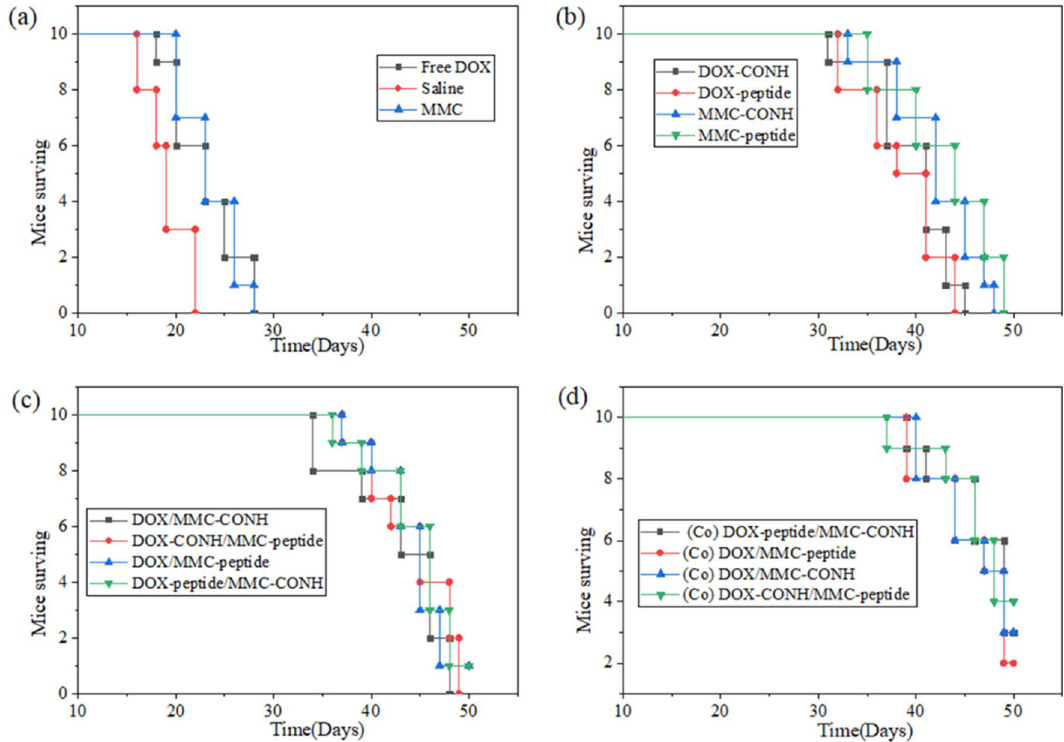
Figure 8. ( a ) Survival curve of the xenograft nude mice bearing the DOX resistant HepG2 tumors treated with free DOX, Saline, free MMC ( b ) Survival curve of the xenograft nude mice bearing the DOX resistant HepG2 tumors treated with DOX-CONH, DOX-peptide, MMC-CONH, MMC-peptide ( c ) survival curve of the xenograft nude mice bearing the DOX resistant HepG2 tumors treated with DOX/MMC-CONH, DOX-CONH/ MMC-peptide, DOX/MMC-peptide, DOX-peptide/MMC-CONH ( d ) (Co) DOX-peptide/MMC-CONH, (Co) DOX/MMC-peptide, (Co) DOX/MMC-CONH, (Co) DOX-CONH/MMC-peptide. After growing drug resistant HepG2 tumors for 3 weeks, these DOX resistant HepG2 tumor-bearing mice were treated with drugs (25 μmol/kg) by tail vein injection every week for four doses (days 1, 7, 14, and 21). The survival time and number of long-term survivors (LTS) until day 50 were monitored (** p < 0.05).